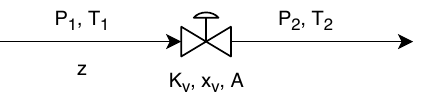
Figure A1. Valve scheme, emphasizing model